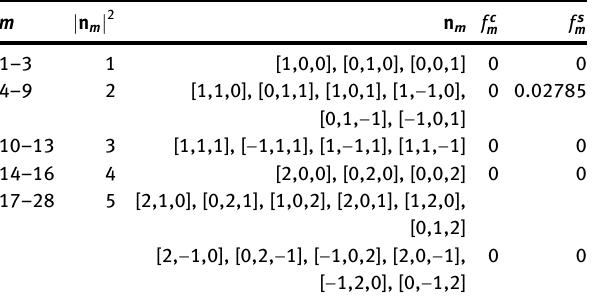
Table  : Results of f c m and f s m obtained from numerical integrals on Eqs. (  ) and (  ); values of f  is  . 